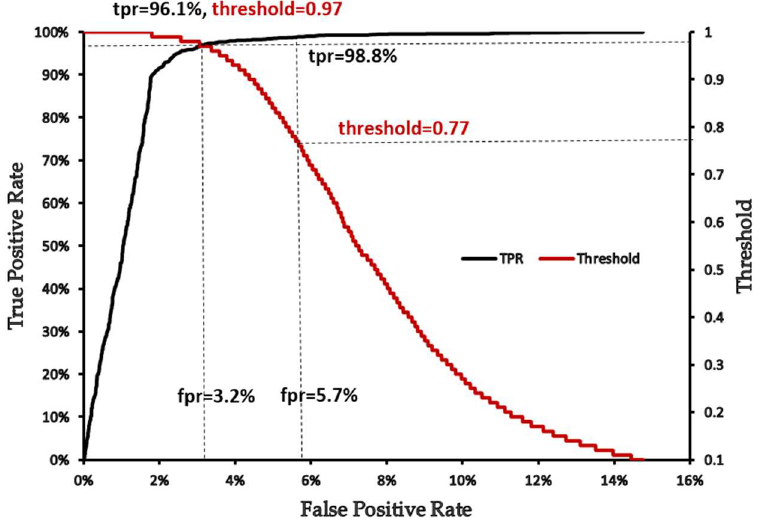
Figure 9. The tpr and fpr of MSF_SSD with different threshold on the test samples.